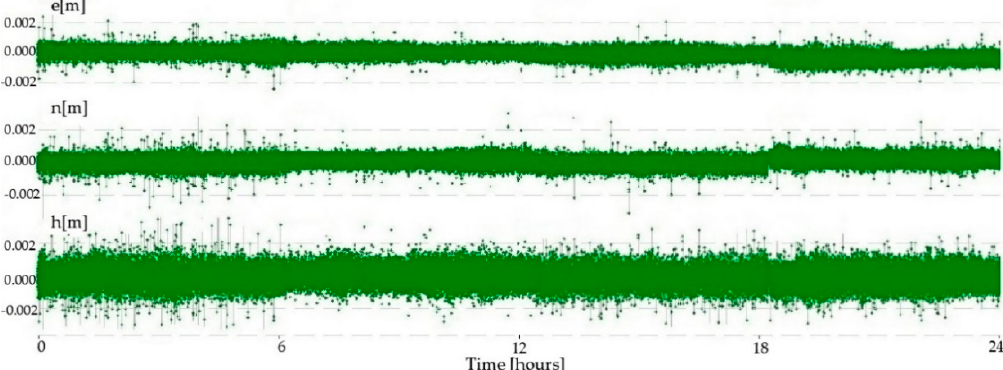
Figure 6. The zero baseline test position errors for the east (e), north (n), and ellipsoid height (h). Table 3. The east ( e ), north ( n ), height ( h ), 1 D , 2 D , and 3 D position differences.